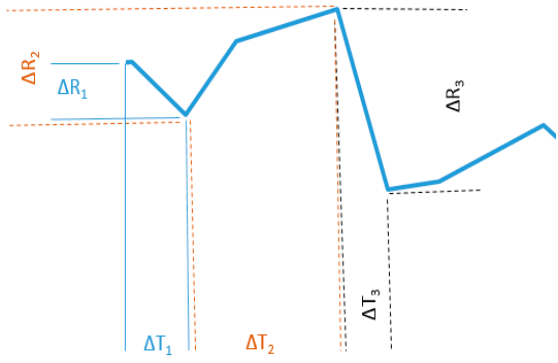
Figure 8. Some examples of calculating R t value.